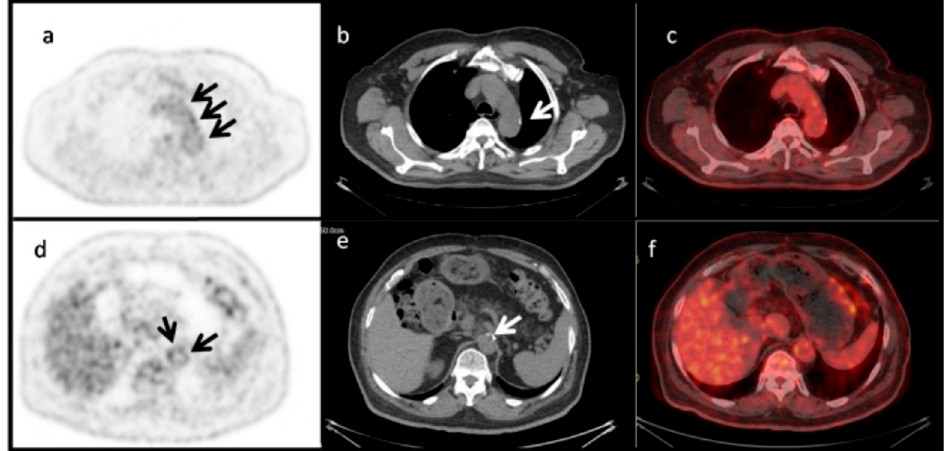
Figure 4. Limited co-localization of aortic wall FDG uptake and CT-detectable macrocalcification. PET images ( a , d ), CT images ( b , e ), and fused PET/CT images ( c , f ) of the aortic arch (upper panel) and abdominal aorta (lower panel) of a 72-year-old man with insulin-dependent diabetes. Macrocalcifications are visible in the low-dose CT images (white arrows in ( b , e )), while faint and more pronounced NaF uptake in other locations is detectable by PET (black arrows in ( a , d )). The SUVmax and SUVmean were 2.9 and 2.2 for the aortic arch, and 2.6 and 2.4 for the abdominal aorta, respectively. Reprinted with permission from Ref. [34]. © 2022, Hellenic Society of Nuclear Medicine.